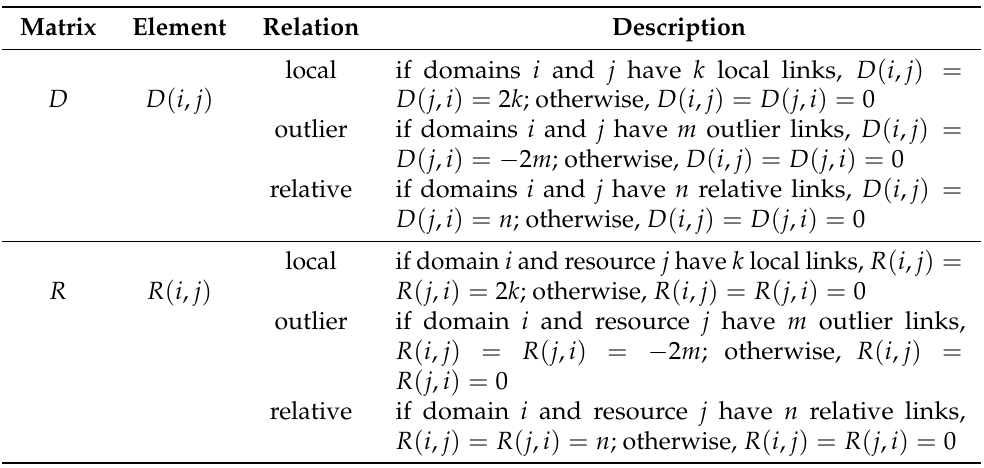
Table 1. Definition and description of the relation